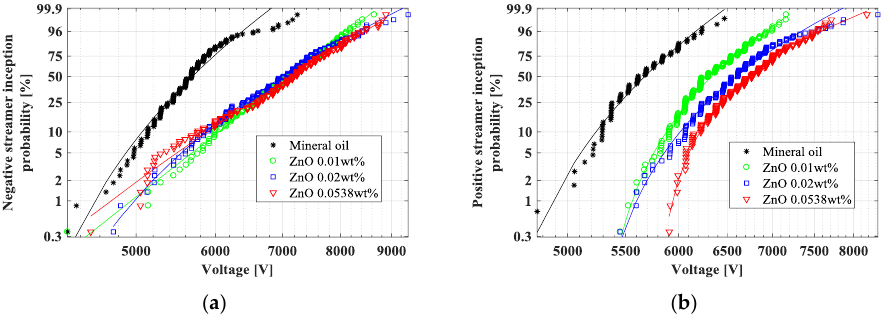
Figure 8. Streamer inception cumulative probability of ZnO nanofluids at different mass concentrations under ( a ) negative and ( b ) positive polarity. The reference data of mineral oil is added for sake of comparison. The corresponding fitting Weibull functions are shown as solid lines.